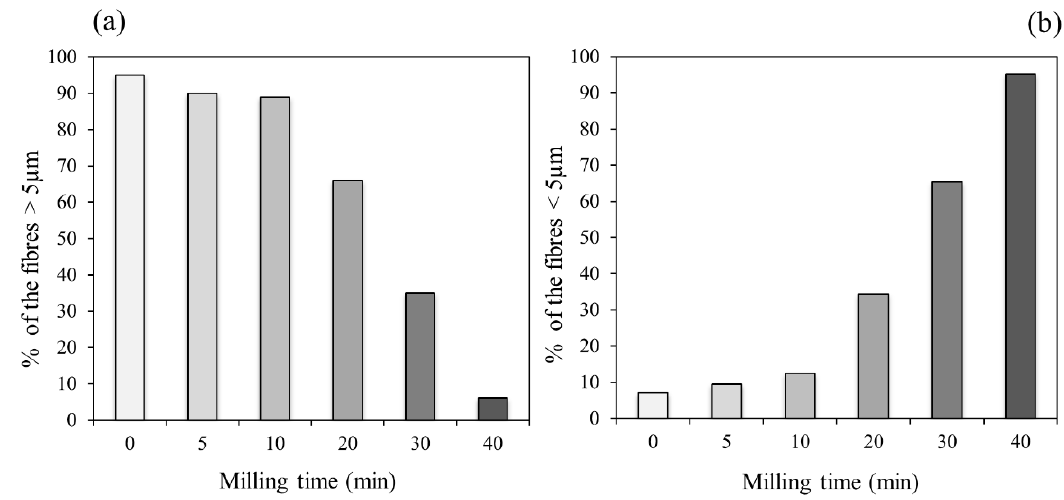
Figure 6. Percentage of long (L > 5 µm) and short (L< 5 µm) chrysotile fibres vs. milling time (from 0 to 40 min). ( a ) Chrysotile fibre length fraction > 5 µm. ( b ) Chrysotile fibre length fraction < 5 µm.